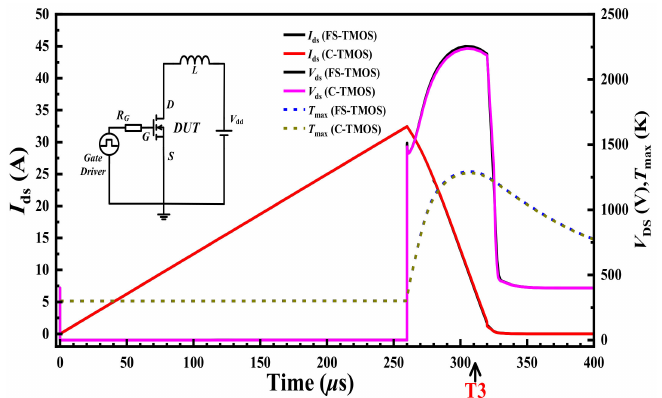
Figure 11. UIS waveforms of FS- and